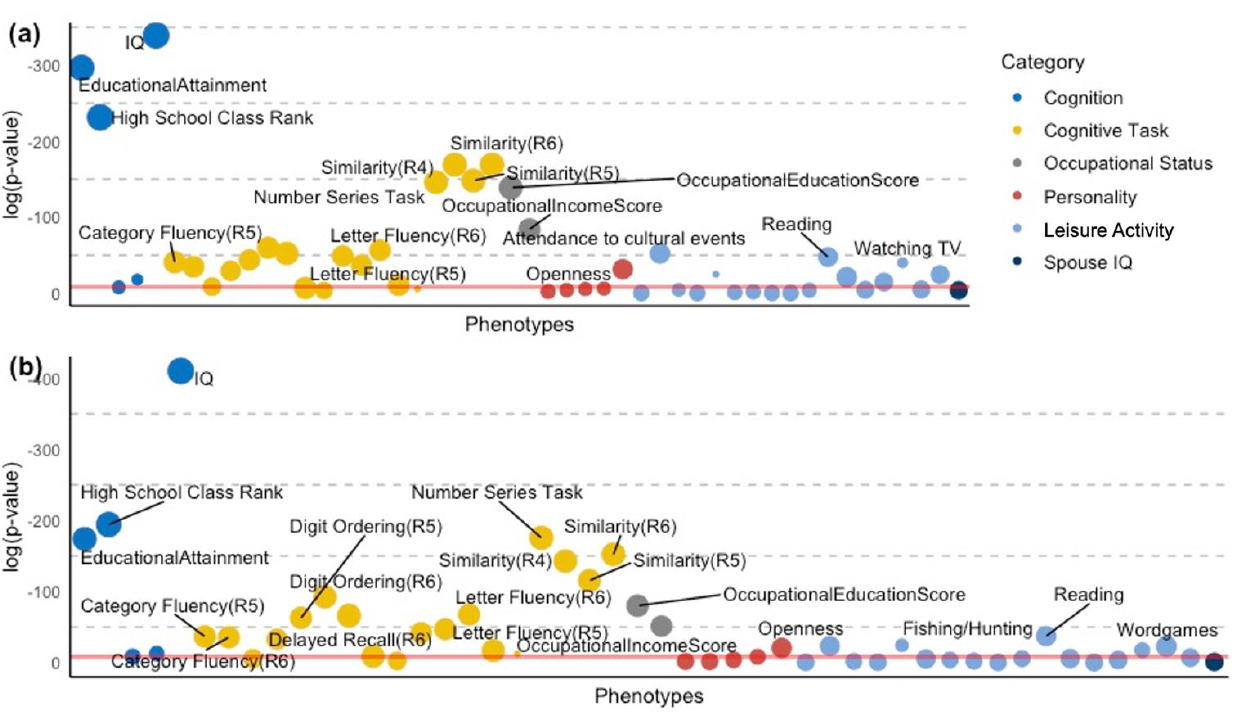
Figure 1. PheWAS plots of the Educational attainment (EA) and Cognitive Performance (CP) GPS in the Cognitive/behavioral phenome of the WLS participants. ( a ) PheWAS plot of Educational Attainment (EA) GPS. ( b ) PheWAS plot of Cognitive Performance (CP) GPS. The cognitive/behavioral phenotypes are presented on the x-axis. The phenotype variables were retrieved from the WLS survey data, primarily from the cognition and leisure activity modules in the 1957, 1992–1994, 2003–2005, and 2011 waves. The red line represents the phenome-wide significance level, og10 of the Bonferroni corrected p -value for multiple testing corrections ( α = 0.05 / (48 tested phenotypes * 4 GPS) = 2.60 × 10 −4 ). The size of each point is proportional to the effect size of each cognitive capacity GPS-phenotype association.